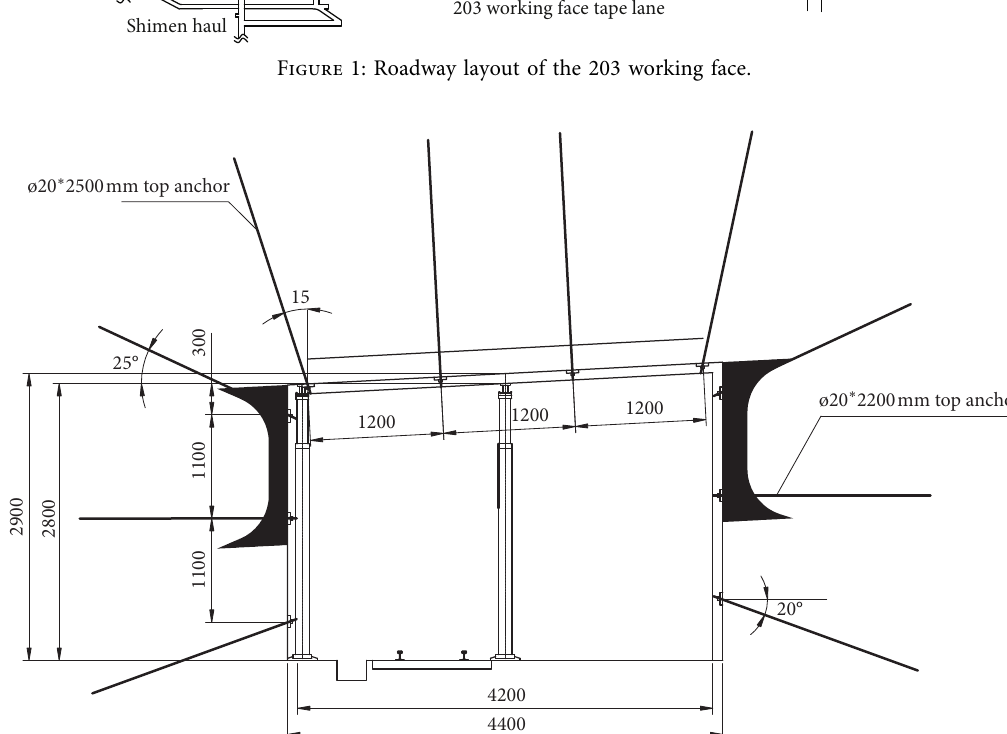
Figure 2: Sectional view of the original support of the belt lane.